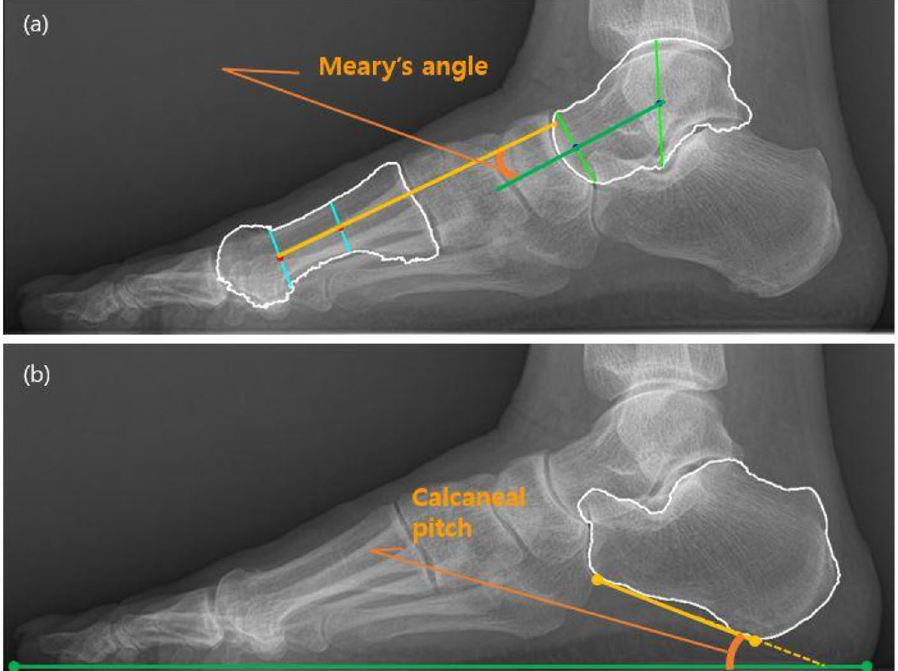
Figure 2. A weightbearing lateral radiograph of a normal foot of a 53 year old female, showing measurement of the Meary angle and calcaneal pitch . ( a ) Meary angle is the angle between the long axis of the talus and the long axis of the first metatarsus. First, the longitudinal axis of the talus is a line drawn through two mid-points. (Green line) One is a mid-point between the cephalad and caudad margins of the talar body, (Longer light green line) and the other is a mid-point between the cephalad and caudad margins of talar neck. (Shorter light green line) The metatarsus axis was determined using the following method. The long axis of the first metatarsus (Yellow line) is drawn by connecting two mid-points equidistant from the cephalad and caudad margins of the first metatarsus at the proximal and distal metaphysial diaphysial junction (blue lines). ( b ) Calcaneal pitch is the angle formed between the line outlining the inferior border of the calcaneus (yellow line) and the weight bearing surface (green